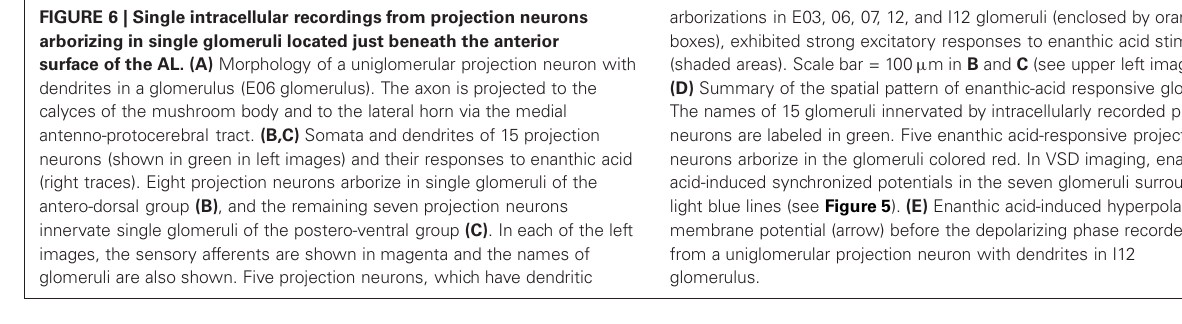
FIGURE 6 | Single intracellular recordings from projection neurons arborizing in single glomeruli located just beneath the anterior surface of the AL. (A) Morphology of a uniglomerular projection neuron with dendrites in a glomerulus (E06 glomerulus). The axon is projected to the calyces of the mushroom body and to the lateral horn via the medial antenno-protocerebral tract. (B,C) Somata and dendrites of 15 projection neurons (shown in green in left images) and their responses to enanthic acid (right traces). Eight projection neurons arborize in single glomeruli of the antero-dorsal group (B) , and the remaining seven projection neurons innervate single glomeruli of the postero-ventral group (C) . In each of the left images, the sensory afferents are shown in magenta and the names of glomeruli are also shown. Five projection neurons, which have dendritic